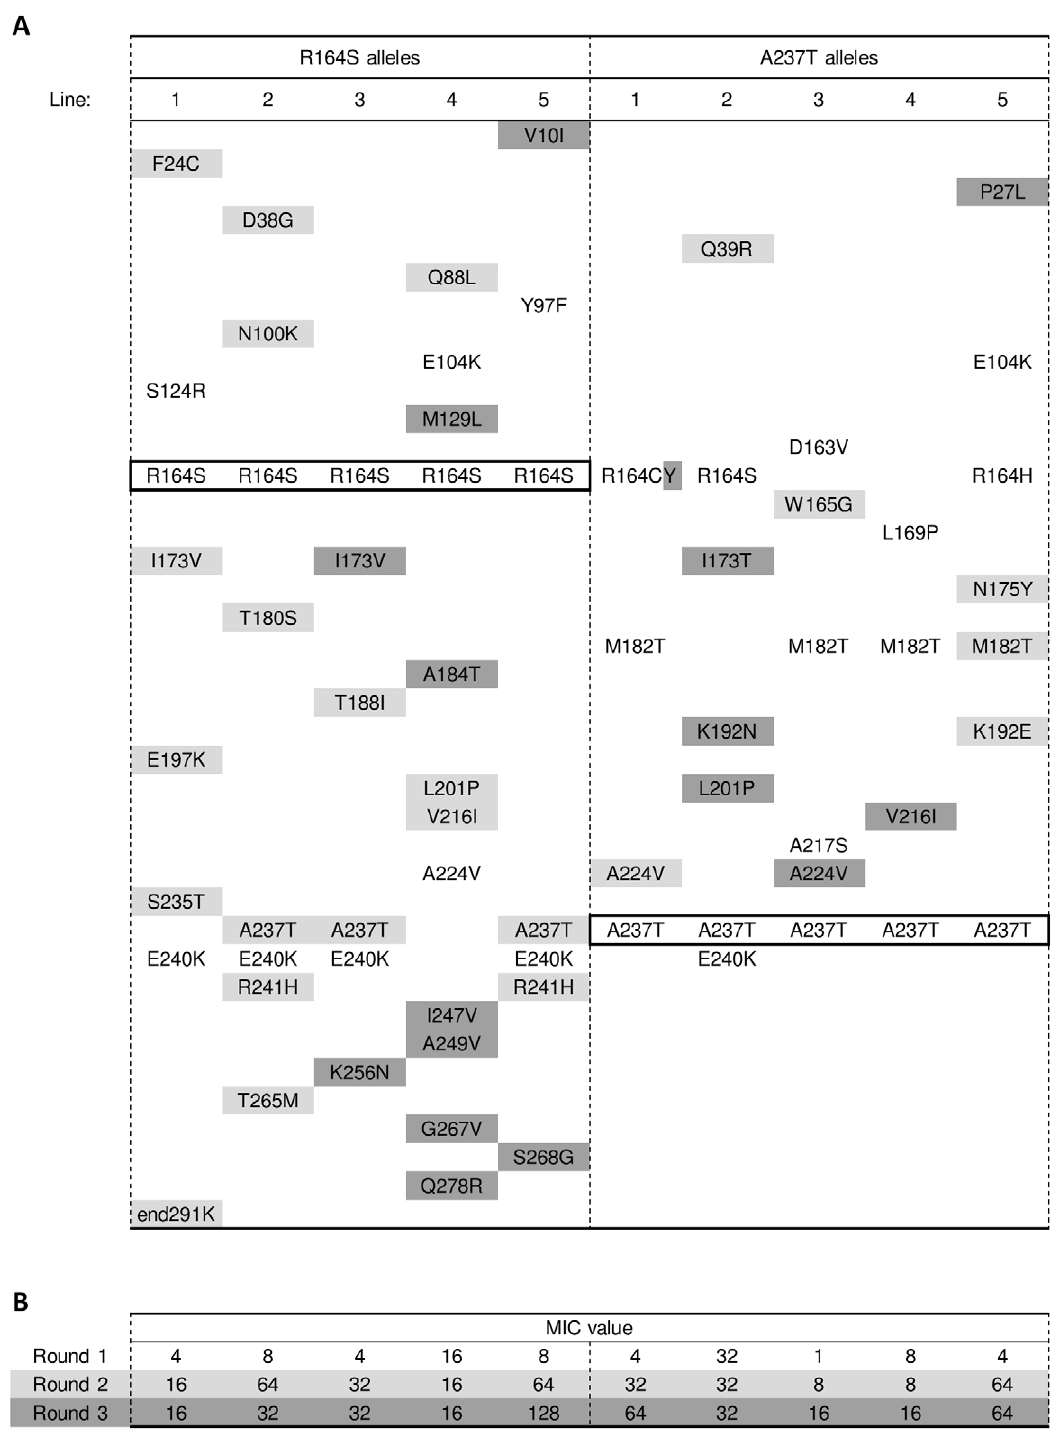
Figure 3. Amino acid substitutions in evolved TEM-mutants R164S and A237T. (A) See legend of Figure 2A for details. The substitutions present in the starting alleles and still present at the end of the experiment have been highlighted by a thick-lined box. Note that line 1 of the A237T alleles acquired substitution R164C after the first round of evolution, and substitution C164Y after the third round. (B) See legend of Figure 2B for details. differences in the resistance in vivo (Table 1), but do not account for the MIC of TEM-1 itself. Thus, regarding the kinetic parameters, the observation that the double mutant exhibits MIC values that we observed epistasis between mutations R164S and G238S with are lower than the R164S mutant, and that are only slightly above respect to cefotaxime hydrolysis: the R164S substitution eliminates